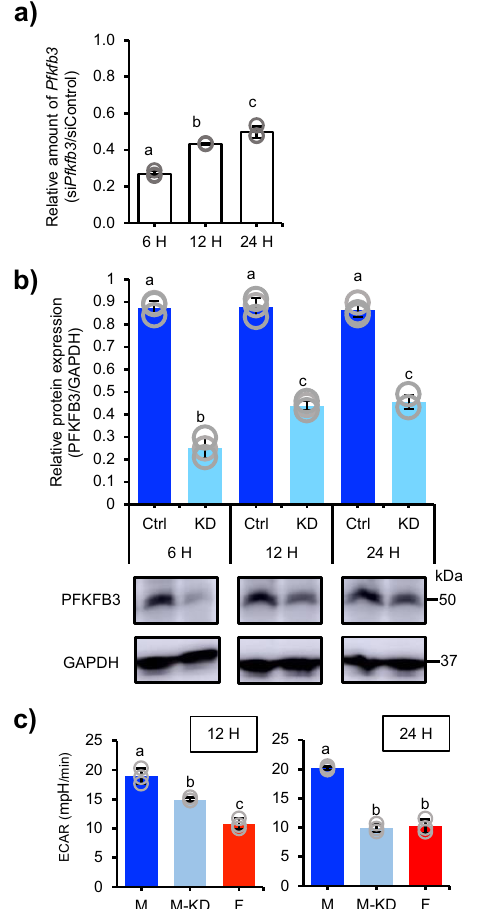
Fig. 5 Impact of Pfkfb3 knockdown on glycolysis in muscle fi bers. a Male quadriceps muscle fi bers were transfected with si Pfkfb3 ( n = 3) or control siRNA ( n = 3) for 6, 12, or 24 h. The amount of Pfkfb3 mRNA was determined by qRT-PCR. The ratios of the amounts of Pfkfb3 mRNA in the si Pfkfb3- and control siRNA-treated fi bers are indicated. b The expressions of PFKFB3 and GAPDH were examined by western blotting at 6, 12, and 24 h after the siRNA transfection. The intensities of the PFKFB3 signals were normalized to those of GAPDH, and the relative amounts are presented as means ± SD ( n = 3 in each group). Full blot images are shown in Supplementary Fig. 5b. c ECARs were examined in the male-derived fi bers treated with control siRNA (M), male-derived fi bers treated with si Pfkfb3 (M-KD), and female-derived fi bers treated with control siRNA (F). The fi bers were treated with siRNA for 12 h (left) or 24 h (right). The data were corrected by the ratio of the mean protein content in the fi bers from the two sexes. Data from three biologically independent samples were analyzed as described in the “ Methods ” section. The bars (means ± SD) with the same letter are not signi fi cantly different from each other ( p <